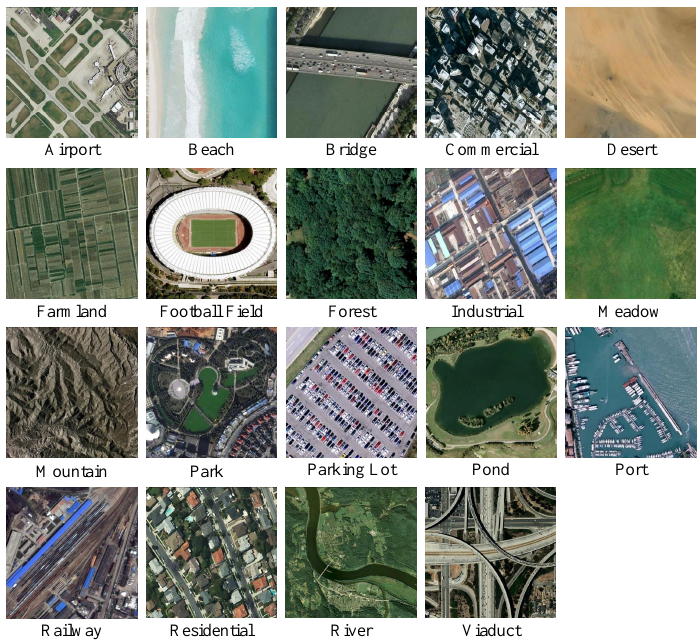
Figure 8. Examples of each category in WHU-RS